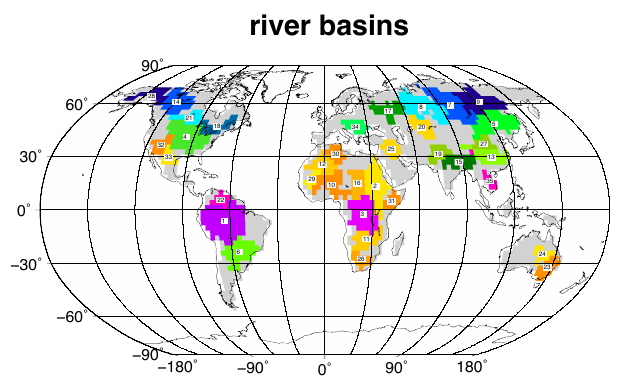
Figure A1. Map of the river basins used in this study, with the Fig. A1. Map of the river basins used in this study, with the names of the river basins given in table A1. names of the river basins given in Table A1.